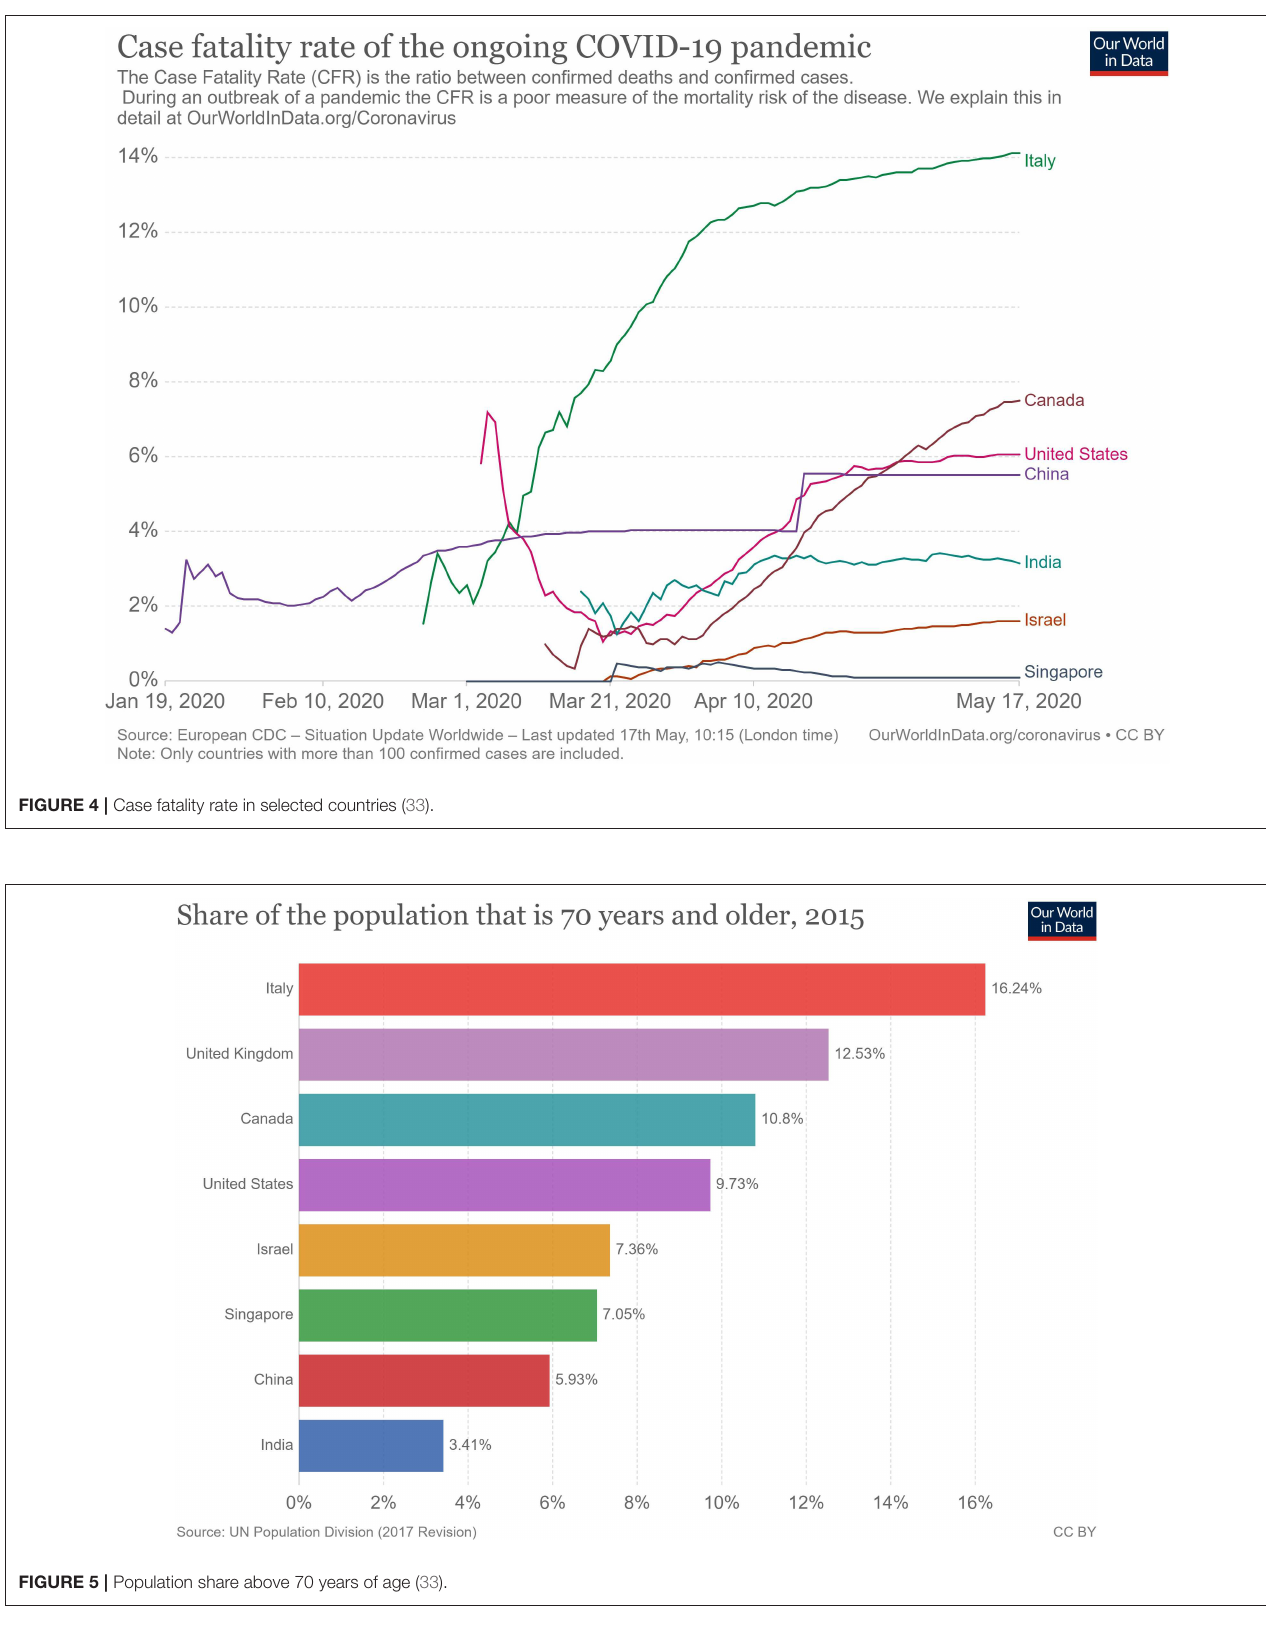
Frontiers in Public Health | www.frontiersin.org